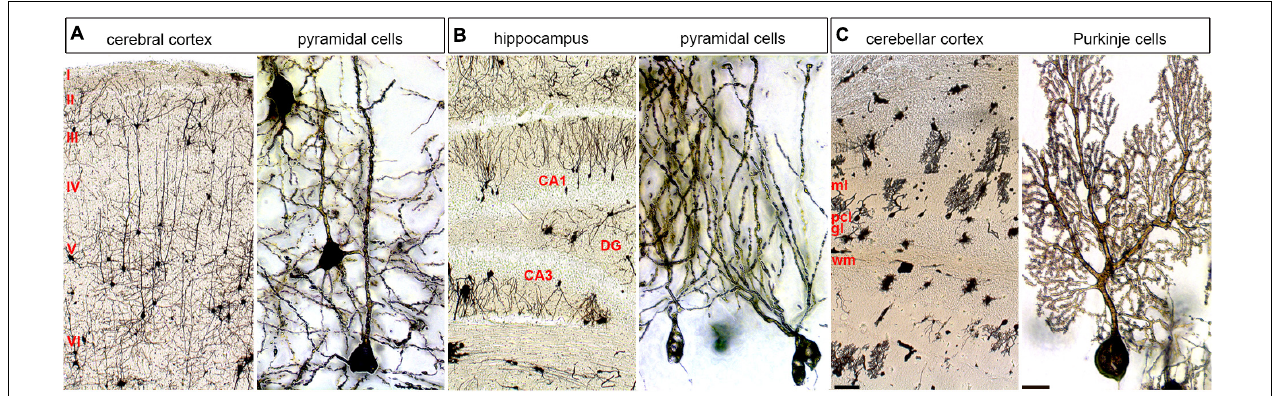
FIGURE 3 | Cellular diversity and specificity in different layered brain structures. The adult mouse brain was stained using a modified Golgi–Cox method. (A) Cerebral cortex shown at low and high power. (B) Hippocampus shown at low and high power shown at low and high power. (C) Cerebellum shown at low and high power shown at low and high power. Pyramidal cells are shown at high power for the cerebral cortex and hippocampus and Purkinje cells are shown for the cerebellum. ml, molecular layer; pcl, Purkinje cell layer; gl, granular layer; wm, white matter; DG, dentate gyrus. The six main layers of the cerebral cortex are labeled with Roman numerals. The scale bar in C (cerebellar cortex) = 100 µ m and applies to all three low power images. The scale bar in C (Purkinje cells) = 20 µ m and applies to all three high power images.